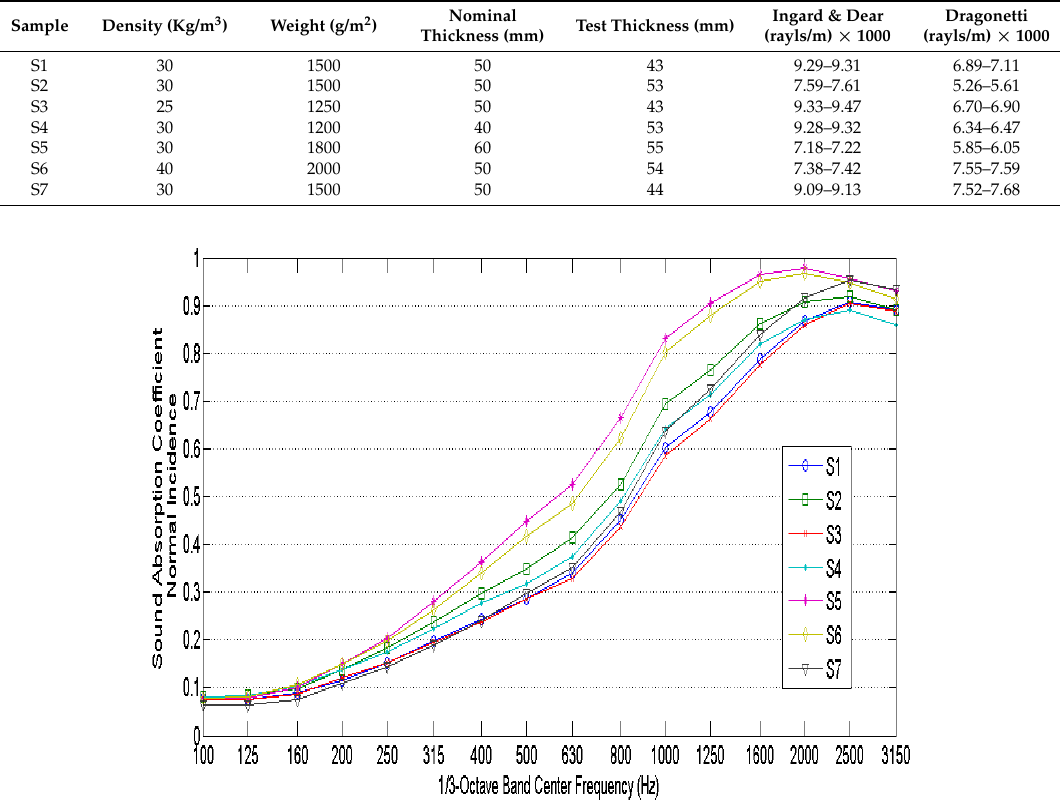
Table 3. Specific airflow resistance measurement results.